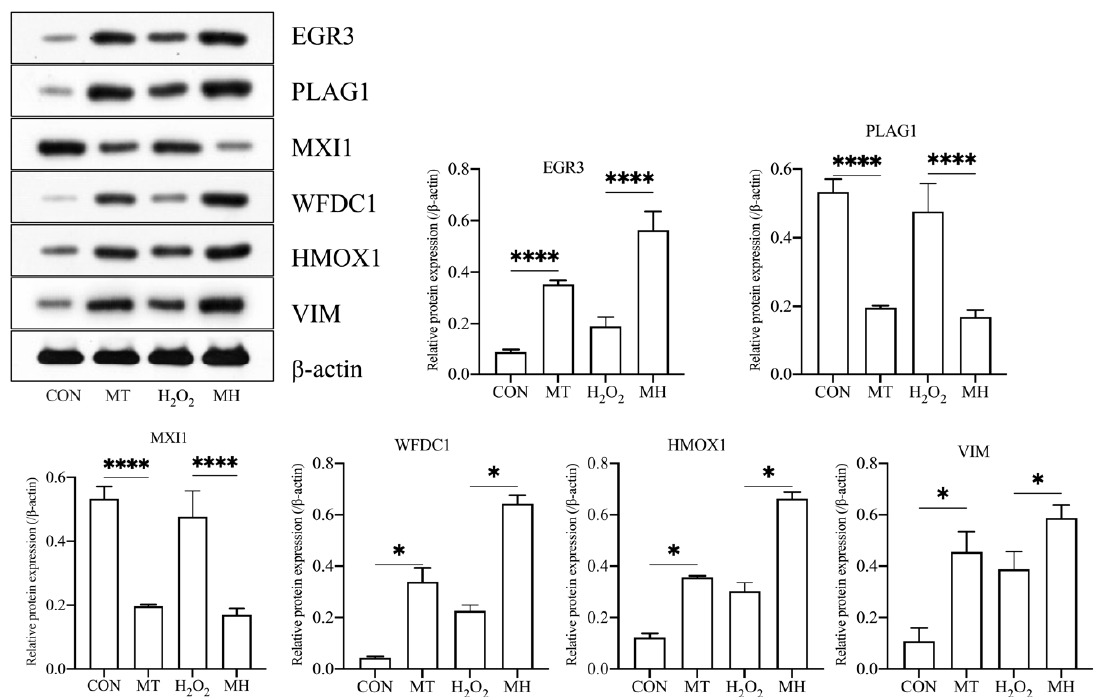
Figure 7. MT protects PTr2 cells from H 2 O 2 -induced oxidative stress by inducing proteins expression. Western blot analysis were performed to detect the protein levels in different group. The data are expressed as the means ± SEM from at least 3 separate experiments. p < 0.05 was considered to be statistically significant. p > 0.05 (ns), p < 0.05 (*), p < 0.0001 (****).